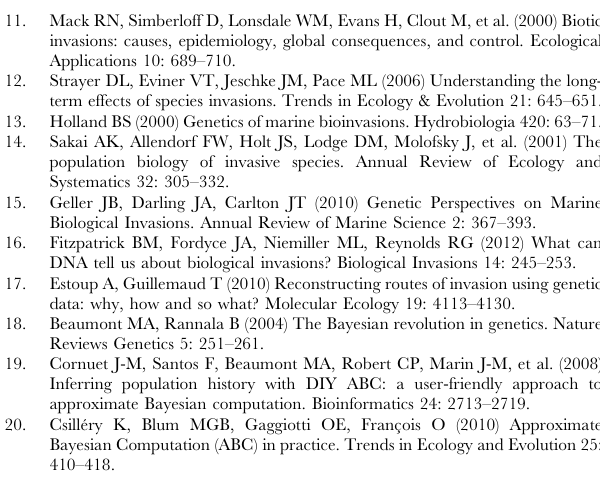
Figure S1 Set of scenarios used to infer the colonisation histories of Microcosmus squamiger using approximate Bayesian computation analyses : A) Independent vs non- independent colonisations, B) Origin of colonising populations, C) Sequence of worldwide introductions. The Y-axis indicates the prior time of events (not to scale) as in Table S1. Abbreviations for populations and groups of populations are as in Figure 4. The unsampled population in A) and C) is indicated by a faint blue colour, and the temporal parameters are as in Table S1. Figure S2 Plot of IncK as described in Evanno et al. [ 80 ] as a function of the number of clusters (K) across the 20 runs : (A) for the whole dataset, (B) for the native populations and (C) for the introduced populations. Table S1 Prior distribution parameters describing the set of scenarios investigated for Microcosmus squami- ger . The time priors were constrained (t1 , t2 , t3 , t4 , t5 , t6) and comprised of split or admixed events. Nau: effective population size of the ancestral populations, Nu: effective population size of the unsampled bridgehead population, N: effective population size of each cluster of introduced populations, SNI: single nucleotide indel. All populations had the same prior regarding their effective population size. Table S2 List of allele frequencies found in each population of Microcosmus squamiger . Population abbre- viations as in Table 1.